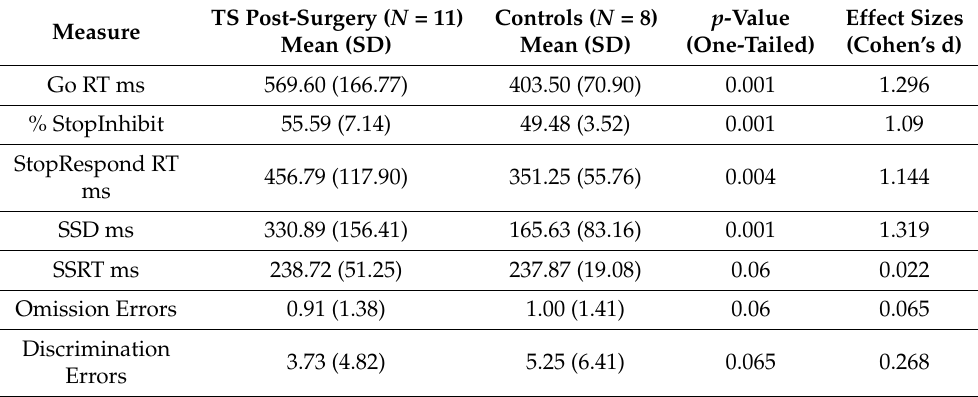
Table 4. Means and standard deviations (in parentheses) of the measures of interest on the stop signal task for the patients with Tourette syndrome (TS) after deep brain stimulation of the internal segment of the globus pallidus (GPi-DBS) and healthy